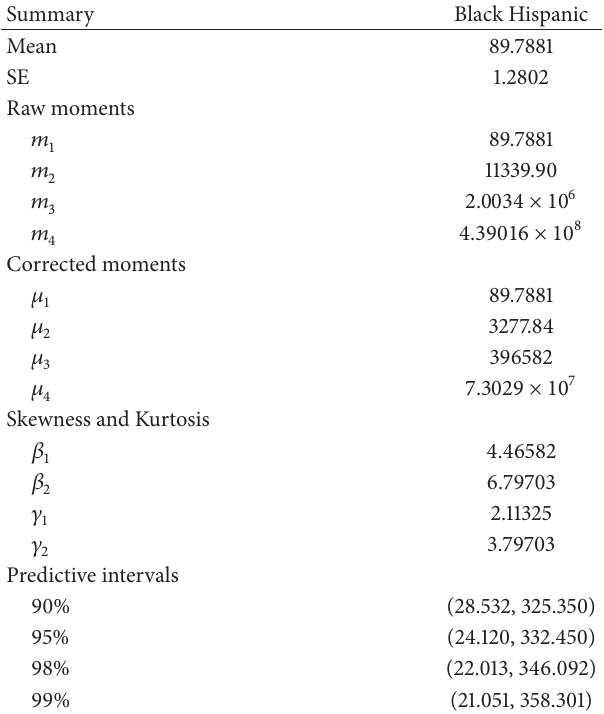
Table 8: Predictive inference for Black Hispanic female breast cancer patients survival